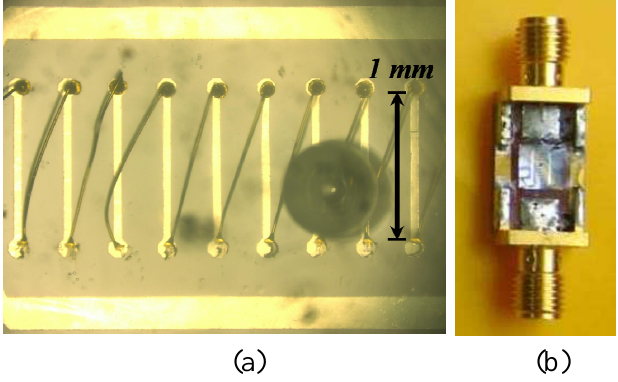
Figure 13. The fabricated (a) bonding wire inductor and (b) the DUT for network analyzing.